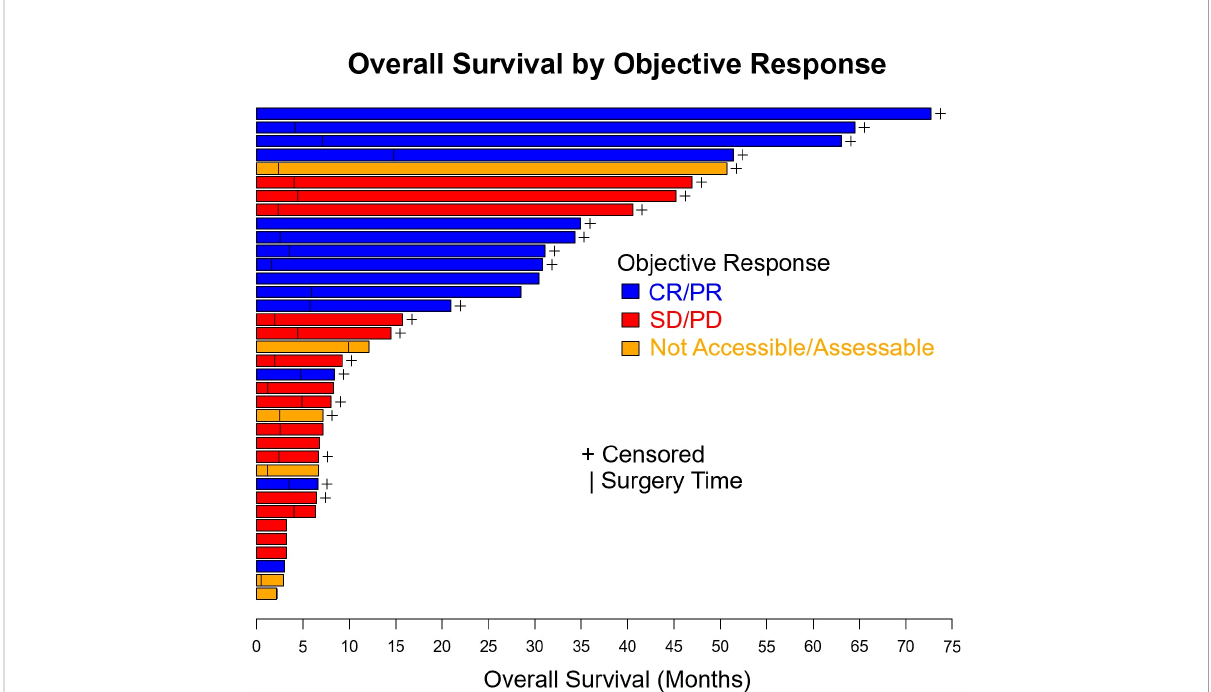
FIGURE 6 Swimmer plot of patients with resectable mucosal melanoma treated with neoadjuvant checkpoint inhibitors with objective response (blue), no objective response (red), and unknown objective response (orange). CR, complete response, PR, partial response, SD, stable disease, PD, progressive disease.